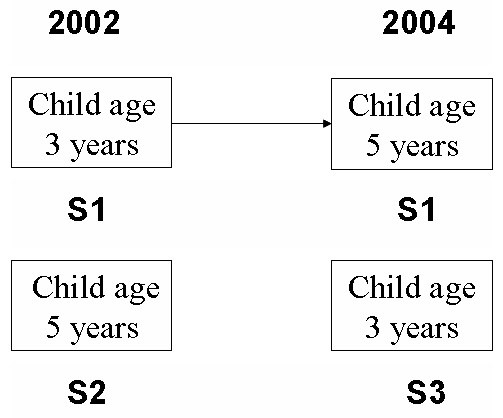
Design of the study.